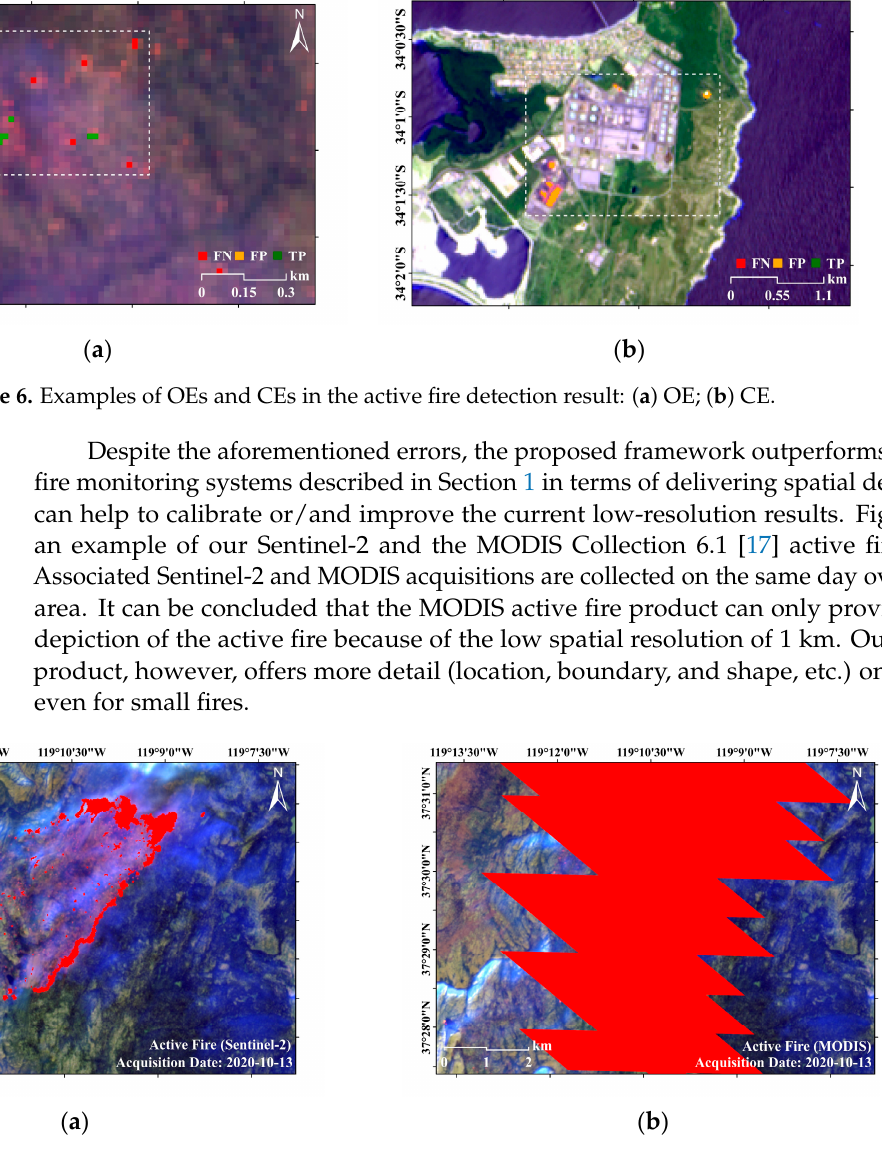
Figure 7. Example of active fire product: ( a ) Sentinel-2 product generated by the proposed framework; ( b ) MODIS Collec- tion 6.1.